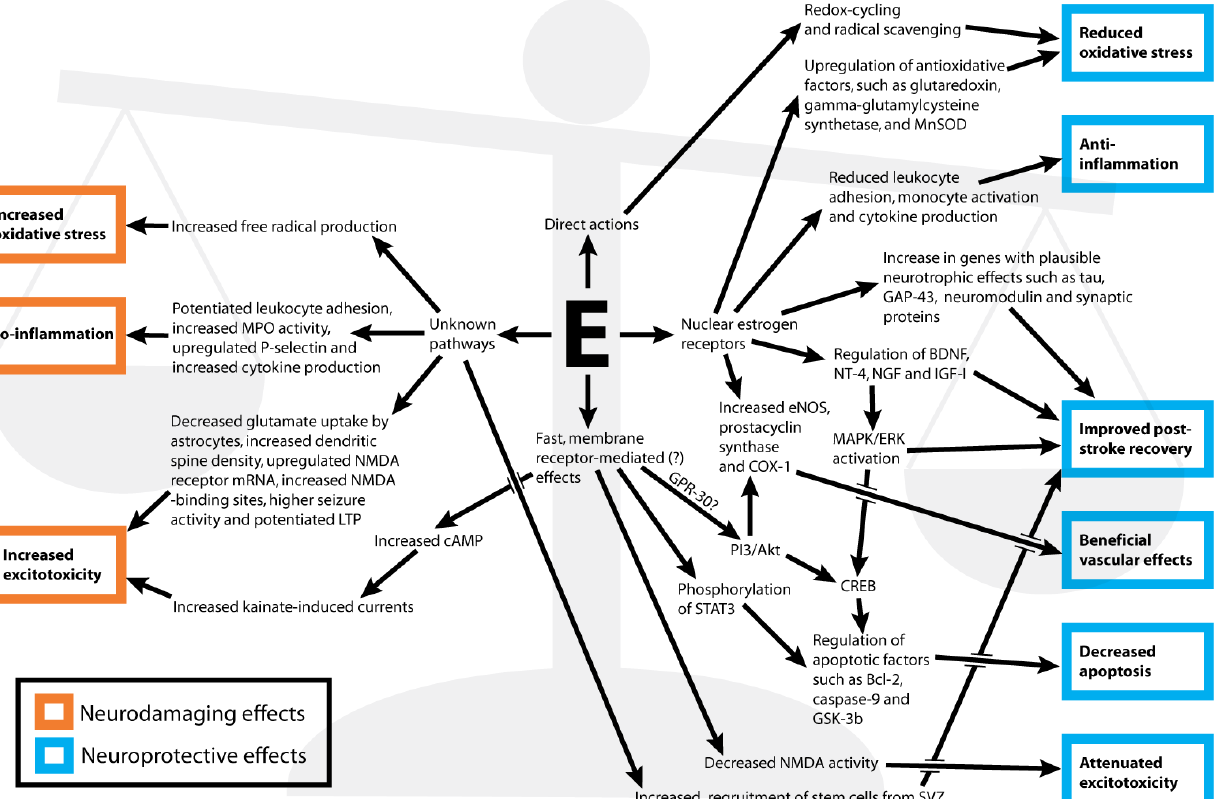
Figure 1. A simplified map of suggested pathways and mechanisms for estrogens’ effects in stroke. Orange and blue rectangles mark plausibly detrimental and protective effects, respectively. The balance in the background symbolizes that depending on the circumstances, such as the dose of estrogen, either the protective or detrimental mechanisms may dominate. The ―E‖ in the middle of the figure is short for ―Estrogens‖ (other abbreviations are detailed above the Introduction). Depicted pathways and mechanisms have previously been reviewed in numerous publications [12,13,34,37–43]. Each part of the figure is matched with exact citations in respective sections throughout the